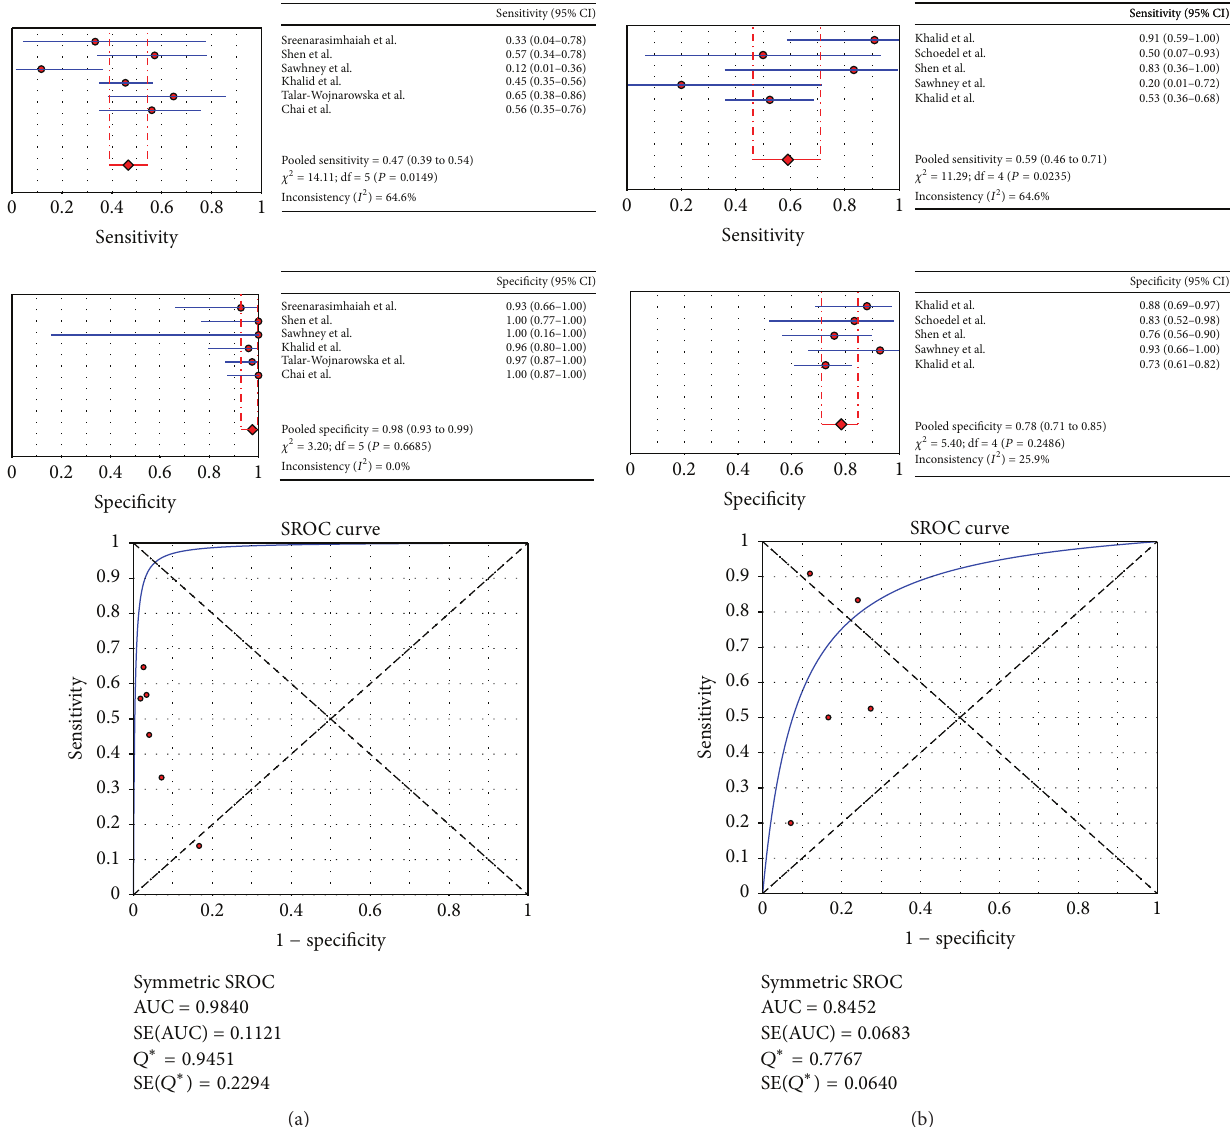
Figure 2: Forest plots of estimates of sensitivity and specificity and SROC in studies of K-ras mutations for the diagnosis of mucinous (a) and benign (b)